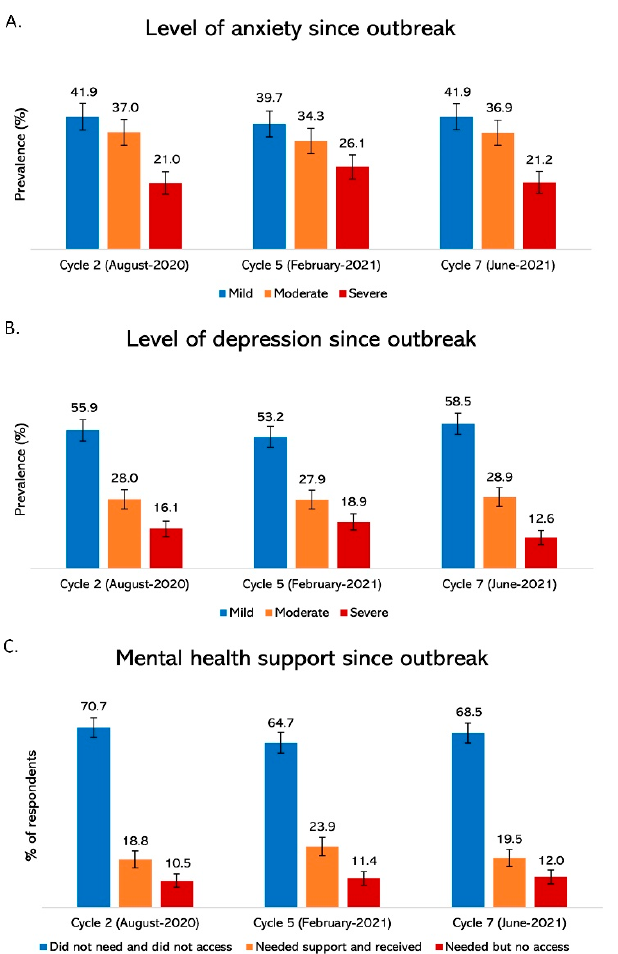
Figure 1. Prevalence of mental health support and access to care in Saskatchewan: ( A ) anxiety; ( B ) depression; and ( C ) mental health support. Table 2. Factors associated with self-reported moderate and severe anxiety compared to mild anxiety, cycle 5 MHRC survey (1–8 February 2021),